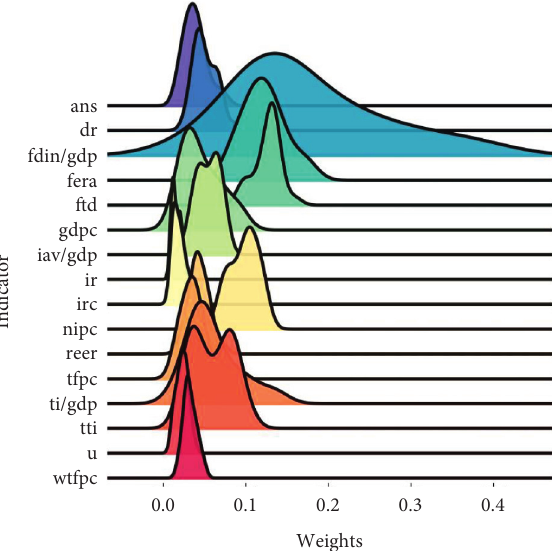
Figure 3: Distribution of indicator weights.